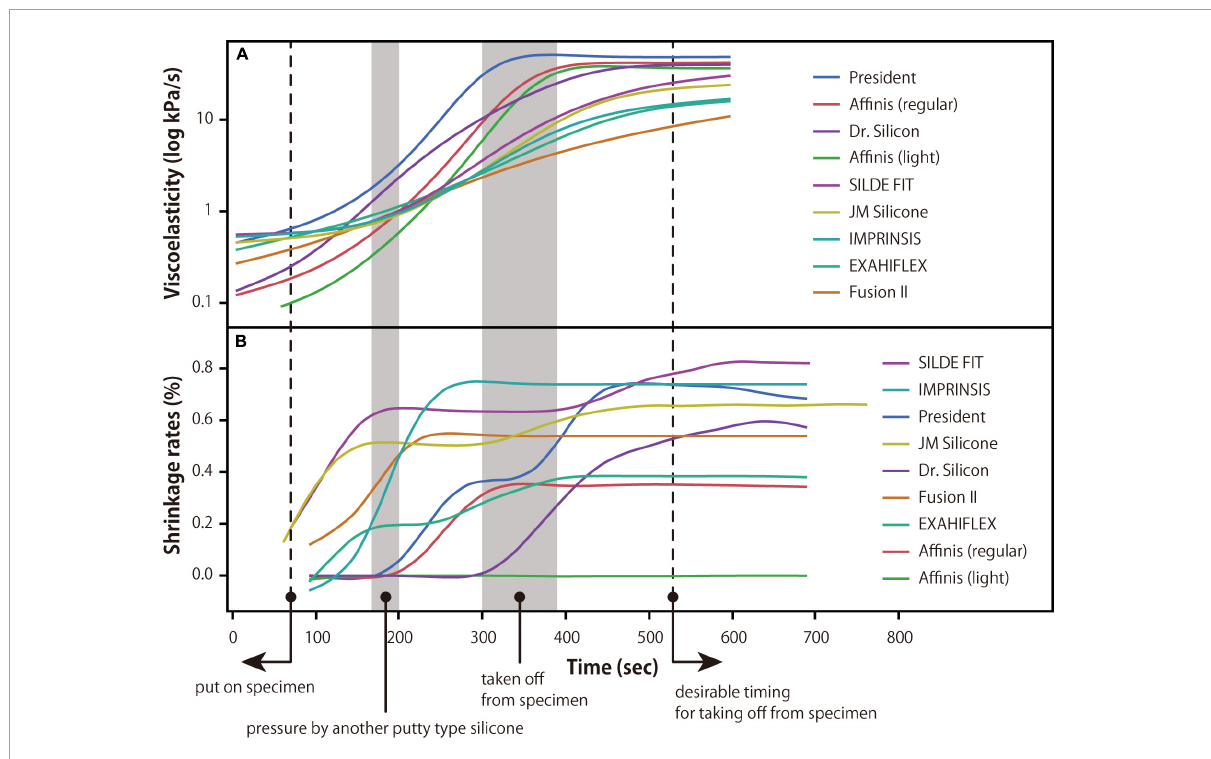
FIGURE2 Dynamic viscoelastic properties and shrinkage rates of silicone materials. (A) Chronological change of viscoelasticity after mixing. (B) Chronological change of shrinkage rates after mixing. The dashed and gray areas in the figure show the timing of silicon application, pressing, and